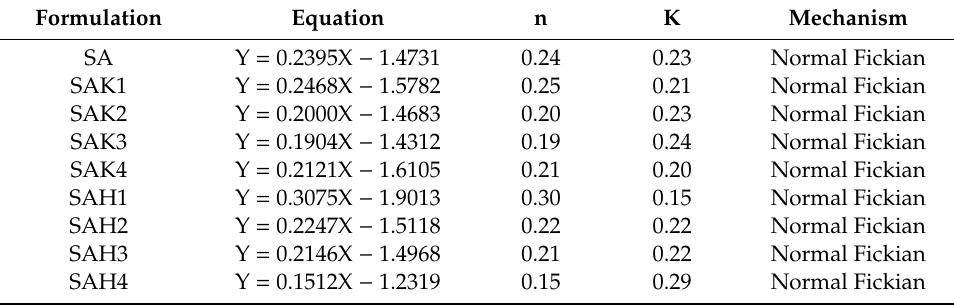
Table 3. Di ff usion constants and mechanism involved in the release process of spores from di ff erent formulations of beads.